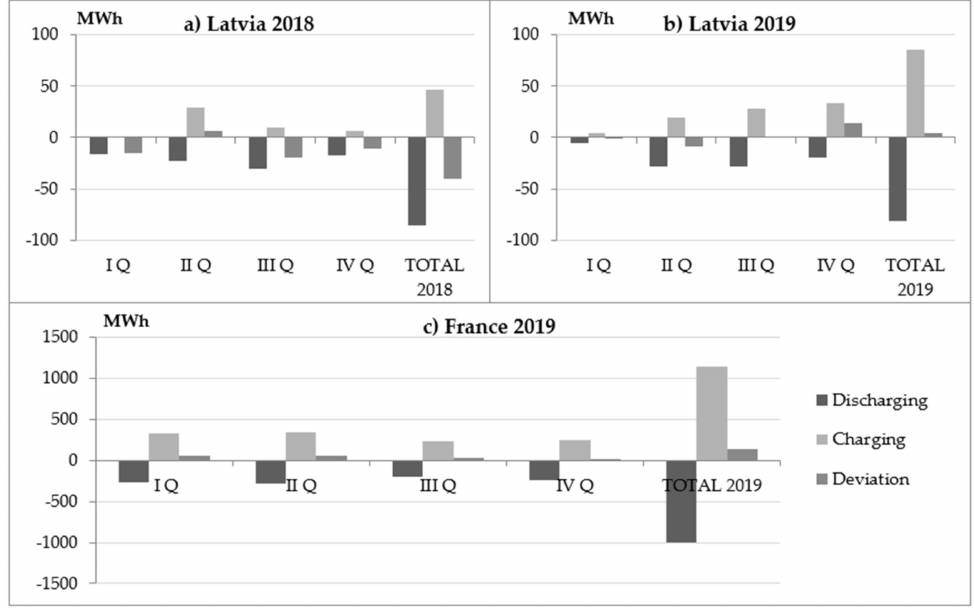
Figure 9. Scheduled market transactions to restore the